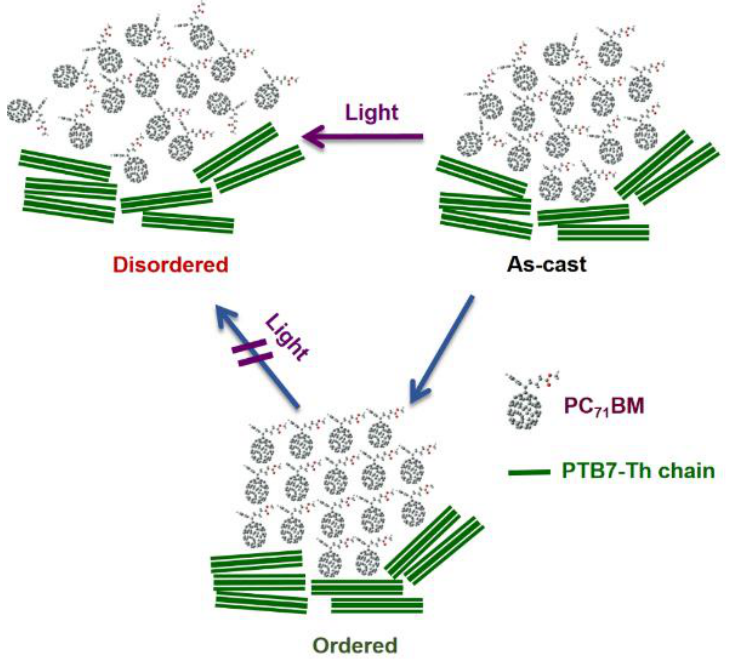
Figure 8. Schematic of two possible paths for the nanomorphology evolution in the PC 71 BM acceptor phase: in the top one light induces disorder and in the bottom one light induced disorder is prevented in a highly crystalline configuration of the PC 71 BM molecules. Reprinted with permission from ref. [116].